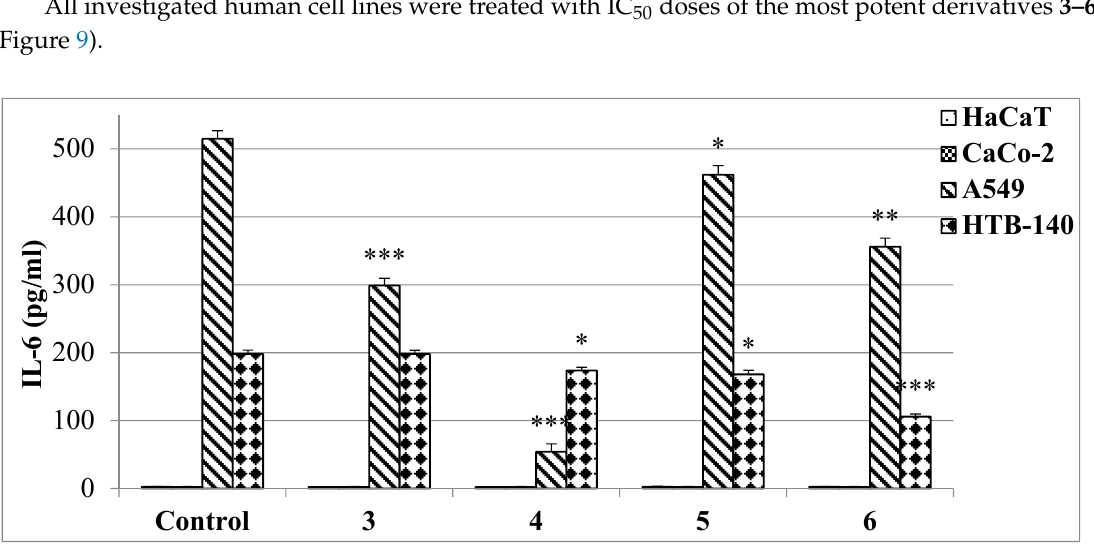
Figure 8. The effect of compounds 3 – 6 on early and late apoptosis or necrosis in A549 cells, detected with Annexin V-FITC/7-AAD by flow cytometry. The lower right quadrant shows early apoptotic cells (Annexin V-FITC positive and 7-AAD negative staining). The upper right and upper left quadrants represent the late stage of apoptotic or necrotic cells (Annexin V-FITC positive, 7-AAD positive, Annexin V-FITC negative and 7-AAD positive staining, respectively). The lower left